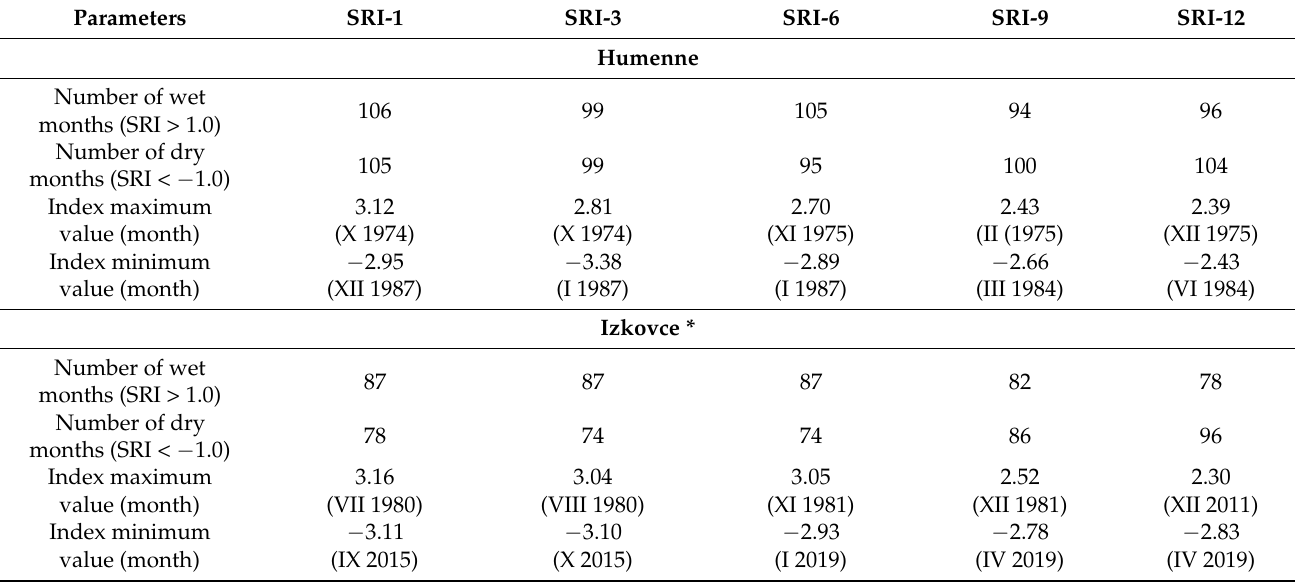
Table 6. SRI parameters over various time scales for Humenne and Izkovce hydrological stations in the period 1970–2019. Parameters SRI-1 SRI-3 SRI-6 SRI-9 SRI-12